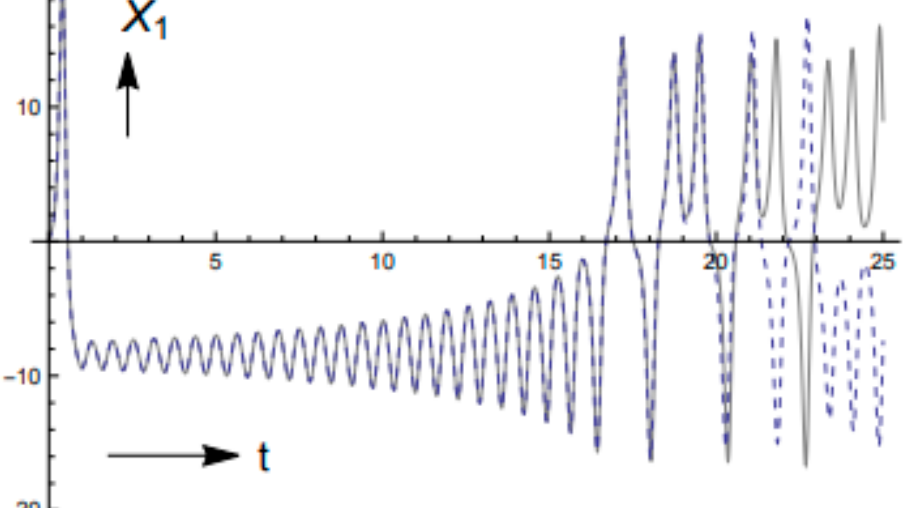
Figure 5. Phase plots of x 4 and x 7 forecast sensitivity over time span [0, 10] in the chaotic regime with controls λ = 28, σ = 10.